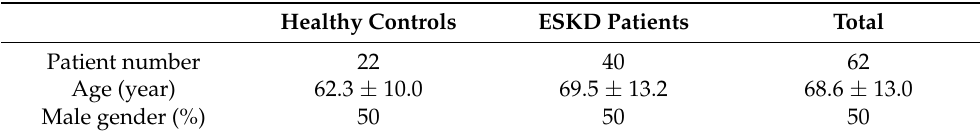
Table 1. Demographic characteristics of human study